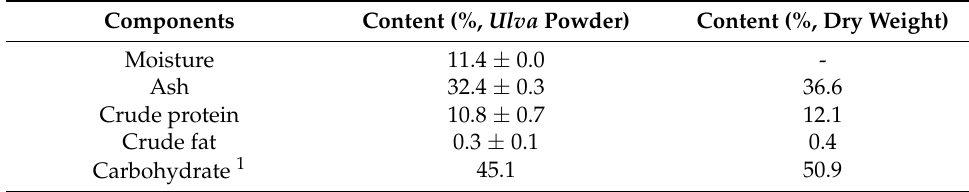
Table 1. The proximity analysis of dried Ulva lactuca